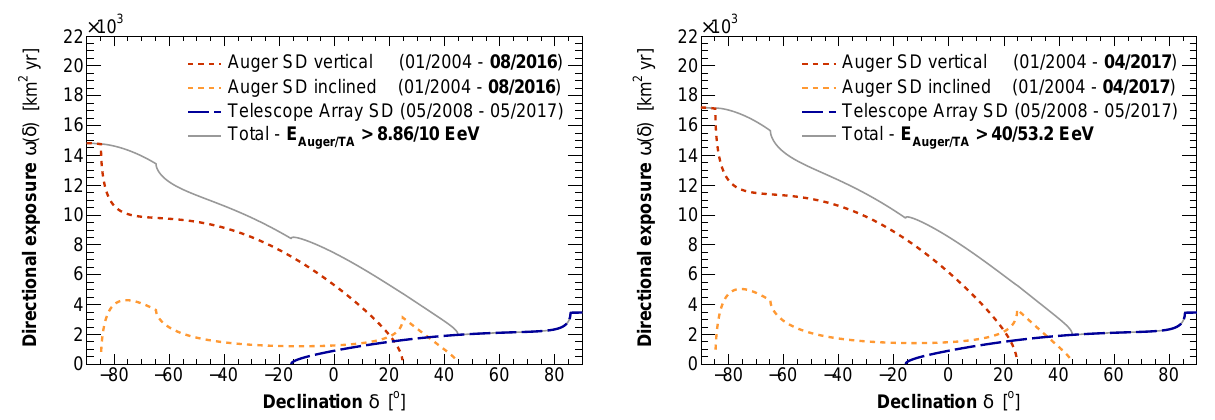
Figure 1. Directional exposure from the surface detectors of the Telescope Array (long-dashed blue line: events up to zenith angles of 55 ◦ ) and Pierre Auger Observatory (dashed red line: vertical events up to zenith angles of 60 ◦ ; dashed orange line: inclined events with zenith angles in 60 − 80 ◦ ). Left: Dataset compiled for E Auger / TA > 8 . 86 / 10EeV. Right: Dataset compiled for E Auger / TA > 40 / 53 .